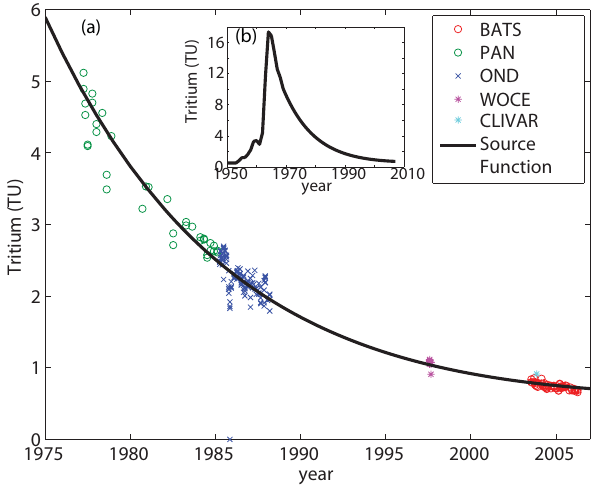
Fig. 1. (a) Surface tritium data collected from 1975 to 2006 at lo- cations near the BATS site, shown in symbols, were compiled to derive a tritium source function appropriate for the BATS study site (solid black curve). See text for an explanation of the data labels. (b) Inset shows the source function from 1950, which includes a modified form of the Dreisigacker and Roether (Dreisigacker and Roether, 1978; Doney and Jenkins, 1988) source function for the years prior to